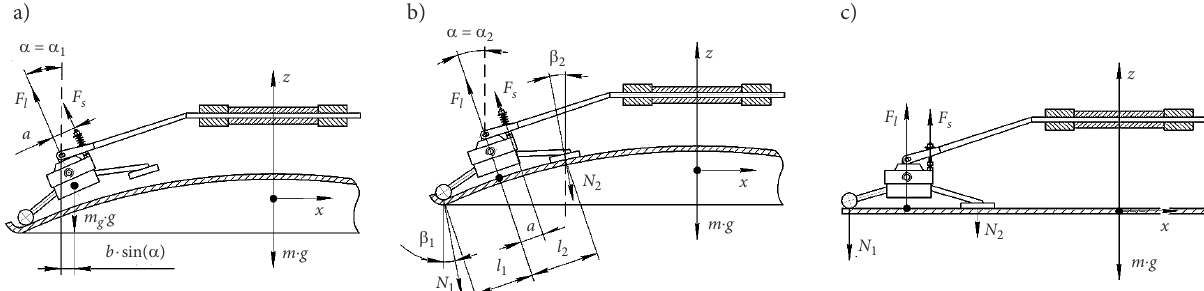
Figure 6. Diagrams for determination of required lifting force of BGD: a – positioning of frame with gripping devices above offset antenna blank; b – grip of offset antenna blank; c – gripping of flat